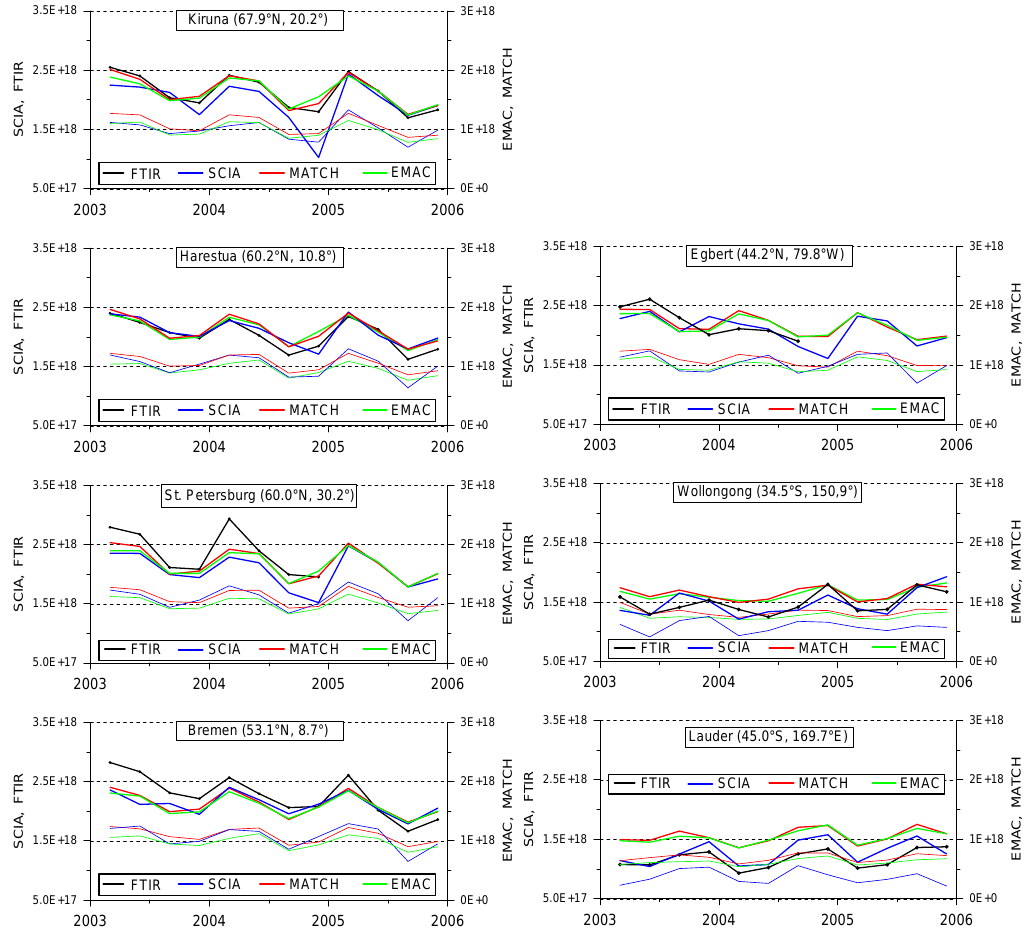
Fig. 6. Comparison of seasonal averages of the CO PVCD from SCIAMACHY and models (coloured lines) with the total CO VCD observed from ground-based FTIR stations (black lines). Thick lines represent CO PVCDs above cloud heights of 0.5 km; thin lines those above 3.5 km. (units: molec/cm²). Note different y-axes for measurements (left) and model results (right). Table 1. Typical errors of the CO PVCDs introduced by uncertainties of the effective cloud height and cloud radiance fraction (CRF). Uncertainties are calculated for a measurement with a CRF of 30% (top) and 60% (bottom) assuming uncertainties of the surface albedo and cloud top albedo to be about ±5% (absolute error of the